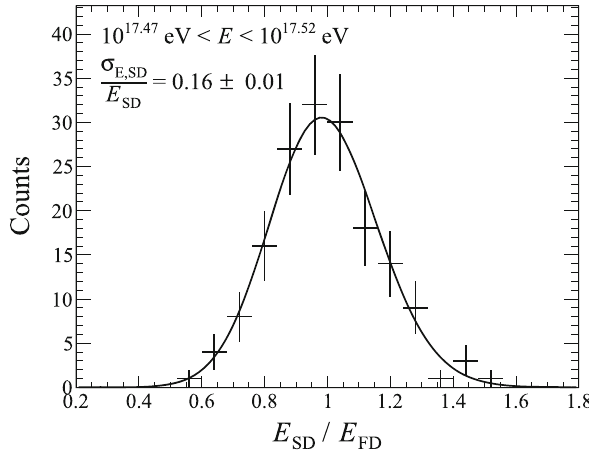
Fig. 8 An example of the ratio of the energy assignments for the SD and FD is shown with black crosses for the energy bin indicated in the plot. The best fit ratio distribution for this bin is shown by the black line